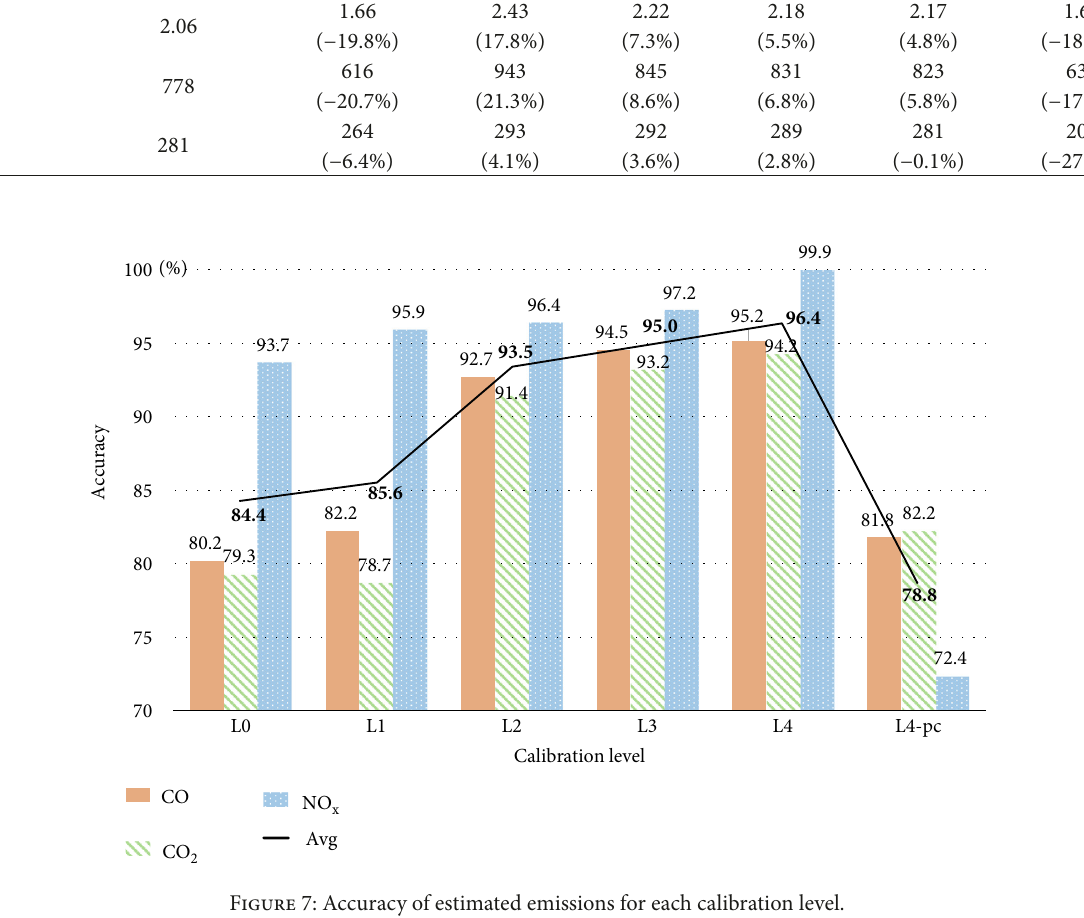
Table 4: Total vehicle emissions and error rates (%) between ground truth and estimated emissions according to calibration levels. Emissions